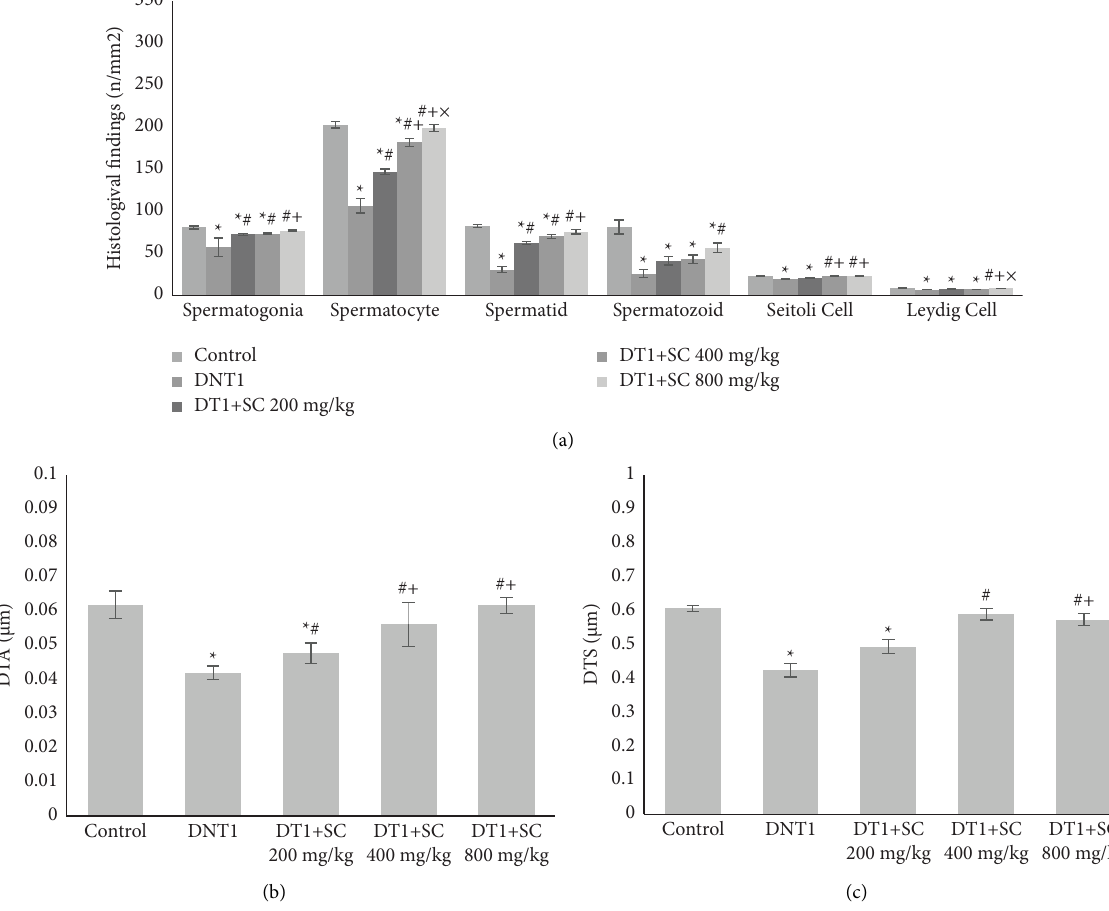
Figure 4: (a) Histological findings of cells count: spermatogonia, spermatocyte, spermatid, spermatozoid, sertoli cell, leydig cell count in mm 2 . (b) Diameter of tunica albuginea. (c) Diameter of seminiferous tubule. Significant differences at p value < 0.05 are shown as not having common character. Values are shown as mean ± SEM. star sign ( ∗ ): difference with control, hashtag sign (#): difference with DNT1, plus sign (+): difference with DT1 +SC200mg, multiplication sign ( × ): difference with DT1+SC400